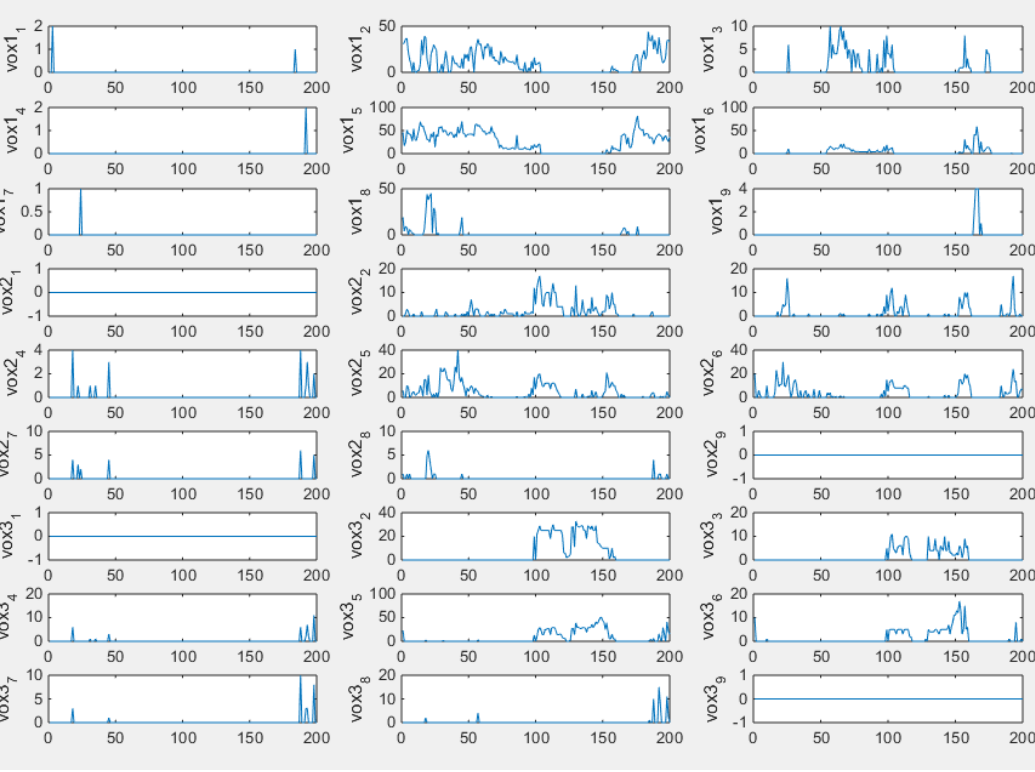
Figure 15. Plots of voxels after thresholding.